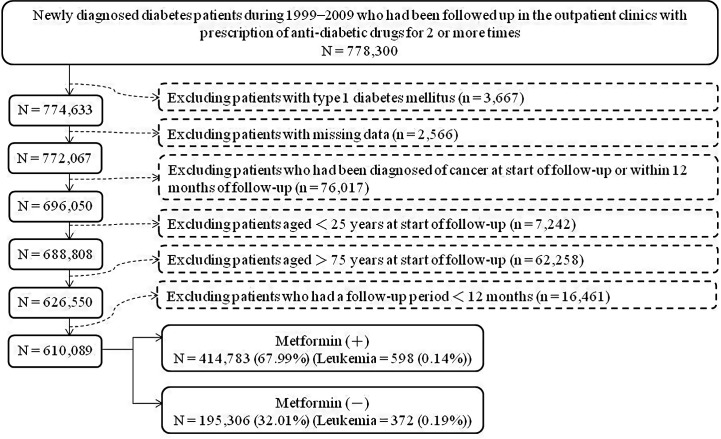
Flowchart showing the procedures followed in creating a cohort of metformin initiators [Metformin (+)] and non-metformin initiators [Metformin (–)] from the reimbursement database of Taiwan’s National Health Insurance.